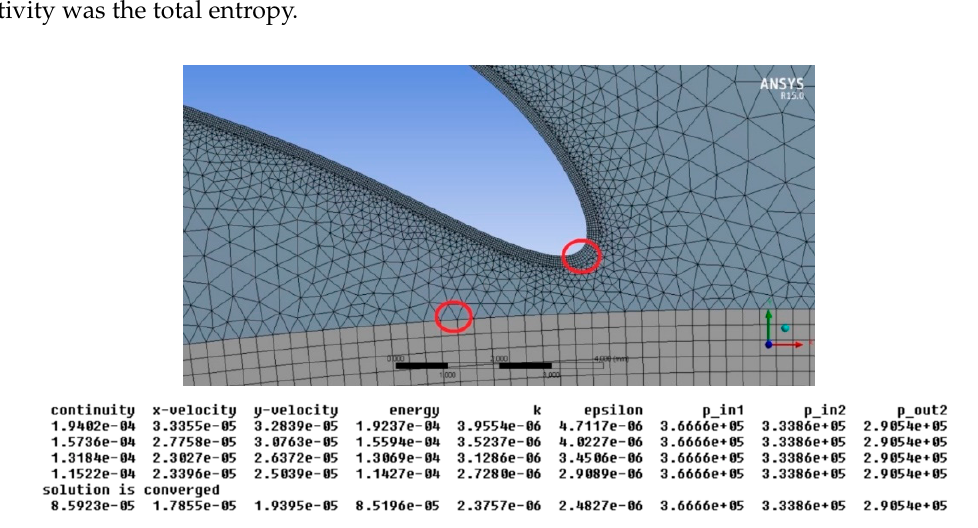
Figure 14. Mesh quality after refinement. The above settings led to an acceptable number of nodes for an accurate two-dimensional study (200,862 nodes and 387,202 elements) and a y+ from 40 to 150 along the blade surfaces. By the same line of reasoning, we obtained 2.6 million hexahedral elements for the 3D study. After a satisfactory convergence was obtained with a residual norm of the order of 10 − 5 , different thermodynamic quantities were extracted from the numerical solution and compared with the analytic model, as shown in Figure 15. The output torque was calculated at each time step of the two- and three-dimensional simulations, to compare the power output with the model prediction.